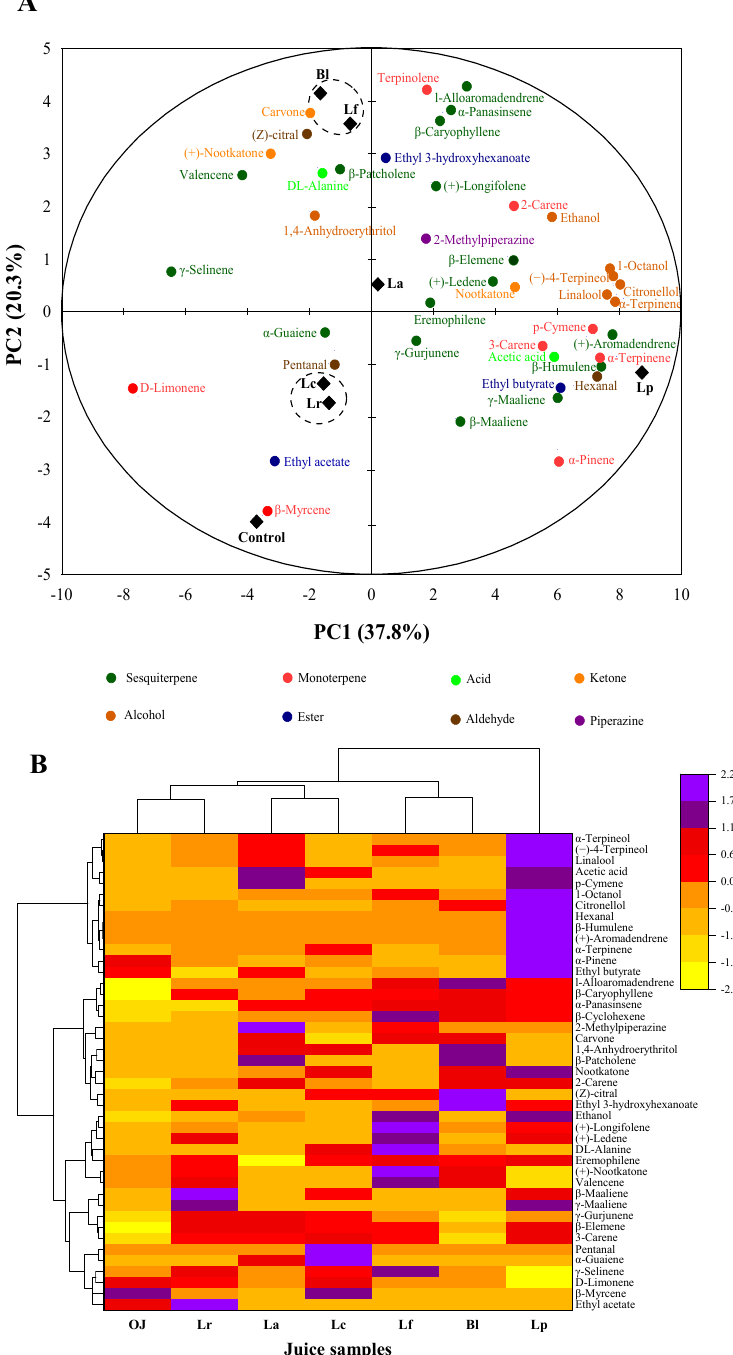
Figure 4. Principal component analysis: ( A ); and heat map ( B ) to evaluate the orange juices fermented by Lactiplantibacillus plantarum (Lp), L . fermentum (Lf), L . acidophilus (La), L . rhamnosus (Lr), L . paracasei (Lc), Bifidobacterium longum (Bl) and control ( n = 3). Control (OJ) was original orange juice.